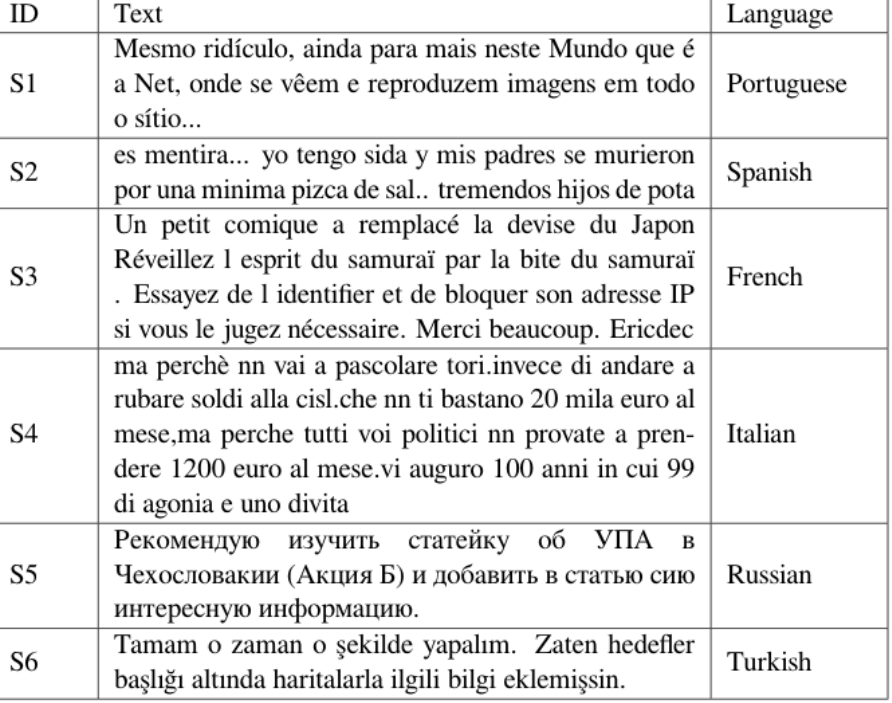
Figure 4. Samples in the test